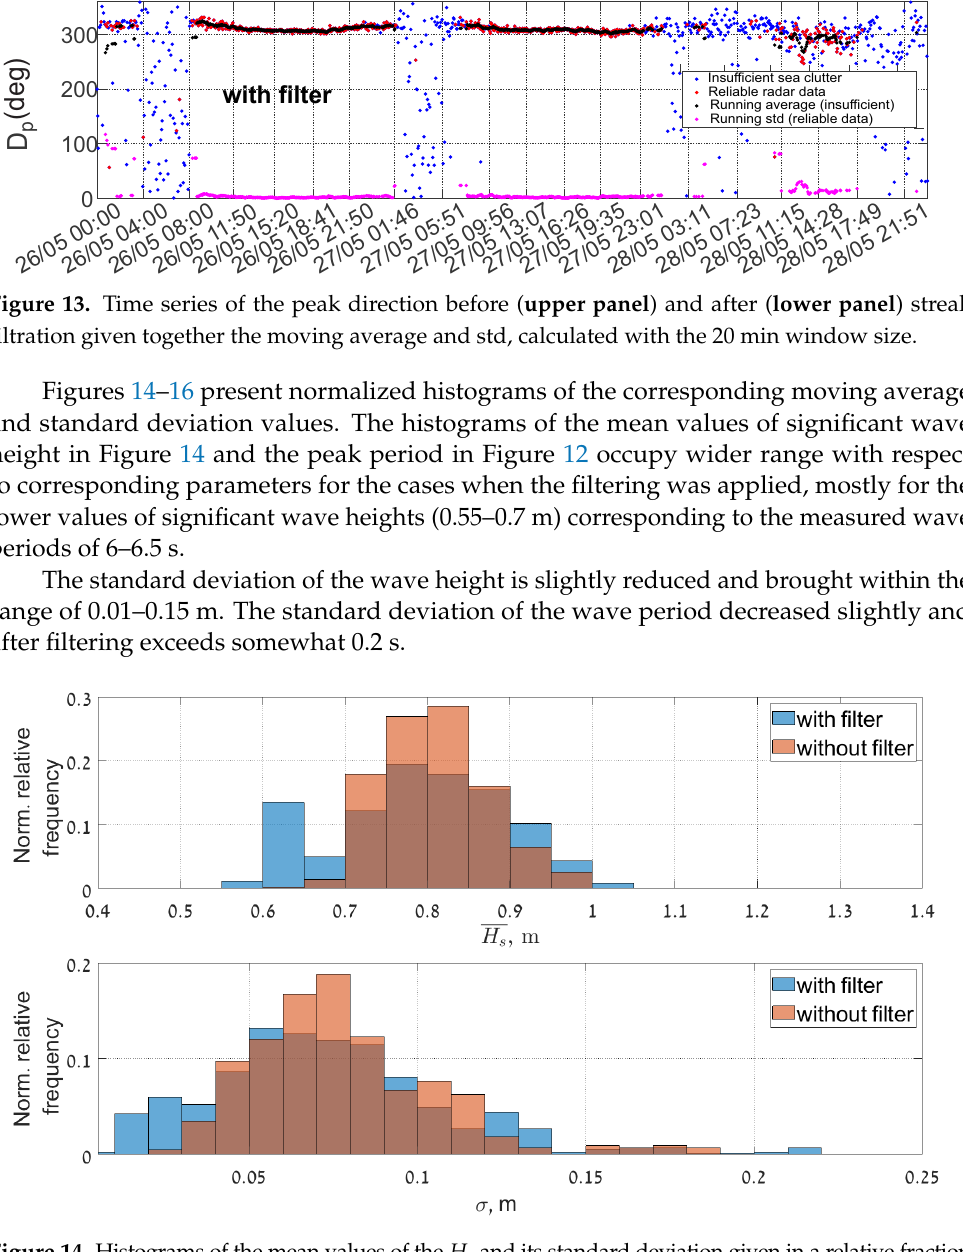
Figure 14. Histograms of the mean values of the H s and its standard deviation given in a relative fraction to the total number of points, bin width for mean value is 0.05 m and for standard deviation 0.01